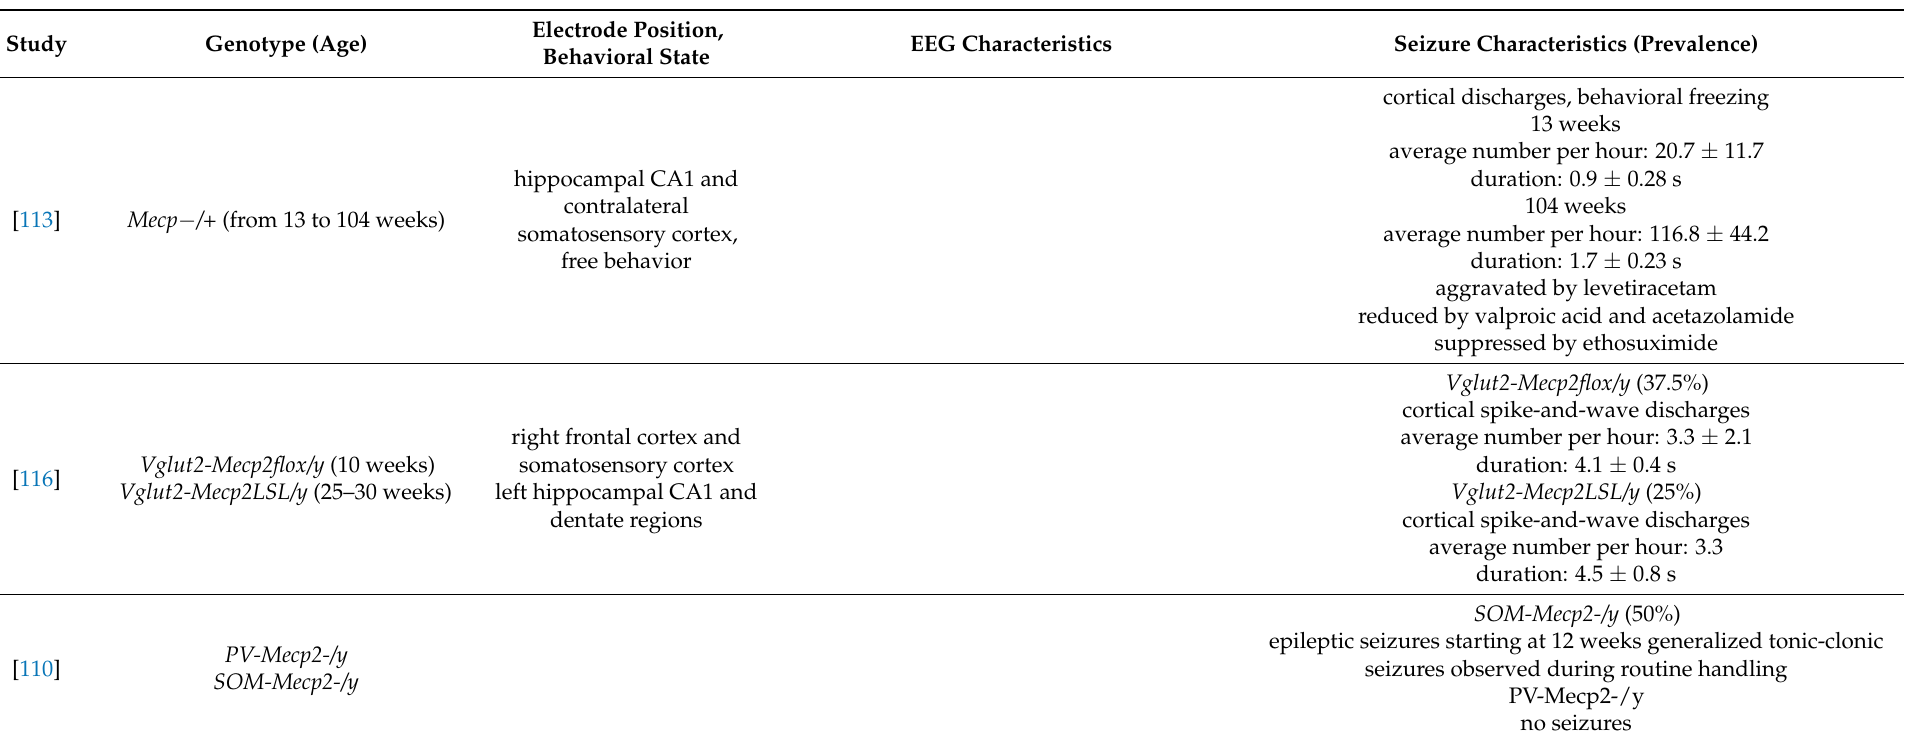
Table 2. Characteristics of EEG and epileptic phenotype in animal models of